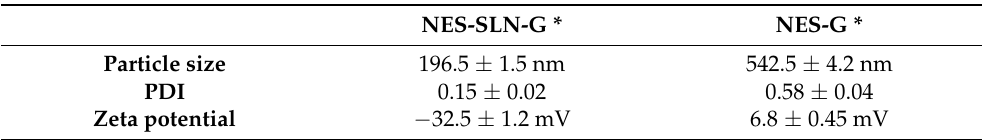
Table 5. Comparison of characterization of NES-SLN-G and NES-G. (*—Values are represented as Avg ± S.D ( n =